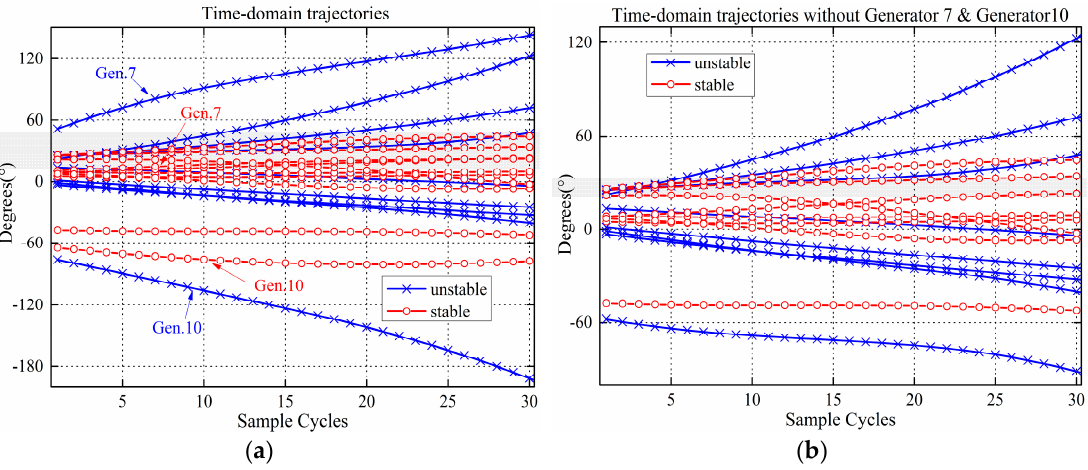
Figure 1. Time-domain trajectories, ( a ) Whole information; ( b ) Without Generator 7 and Generator 10.